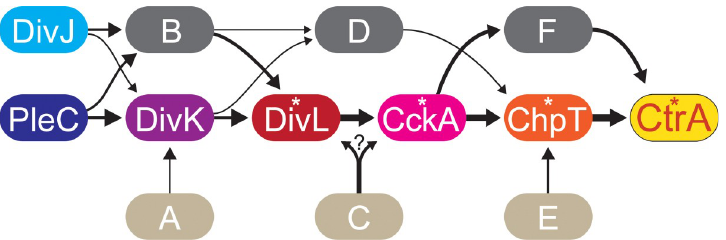
Fig 12. Model of the cell cycle regulatory cascade controlling CtrA activity in H . neptunium . DivJ, PleC and a thus- far unidentified factor (oval A; 1%) control the phosphorylation state of DivK. The role of DivK is subordinate to that of an additional regulator (oval B; � 23%), which receives input from DivJ and PleC and potentially other proteins. DivK and the unidentified regulator transfer the majority of the signal to DivL, from where it is passed on via CckA and ChpT to CtrA. Additional unidentified factors feed into DivL and/or CckA (oval C; 44%) and ChpT (oval E; 10%), although some of the signal from DivK could also bypass DivL and CckA via an additional pathway (oval D; 2%). Finally, there may be a pathway that acts in parallel to ChpT to transfer signals from CckA to CtrA (oval F, 29%). The thickness of the lines is proportional to the fraction of the total signal reaching CtrA that is transferred via the corresponding connection (as indicated by the percentages above). Note that the sum of the input signals amounts to more than 100%, because some genes are present in the regulons of multiple input proteins. Essential proteins are marked with